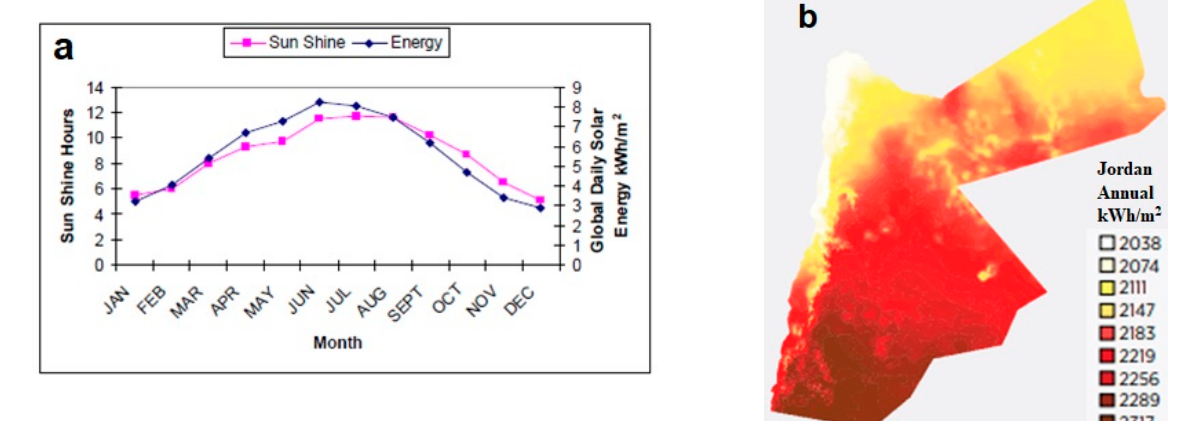
Figure 1. ( a ) Sunshine hours and global daily solar energy intensity of Jordan [26]. ( b ) Annual global irradiation distribution map of Jordan [27].